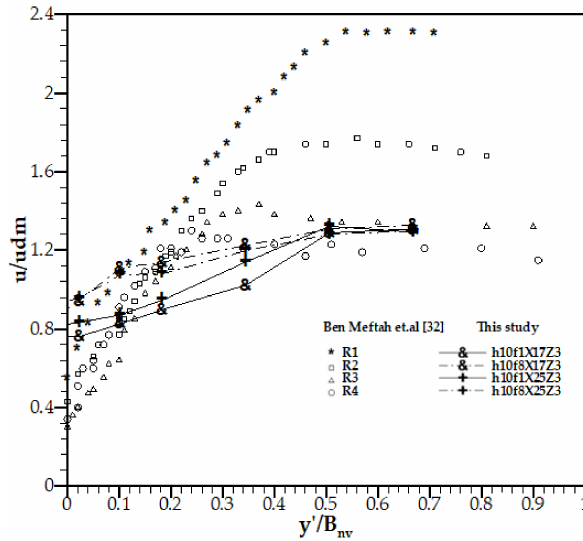
Figure 13. Transversal profiles of non-dimensional velocity distributions versus y/B nv .